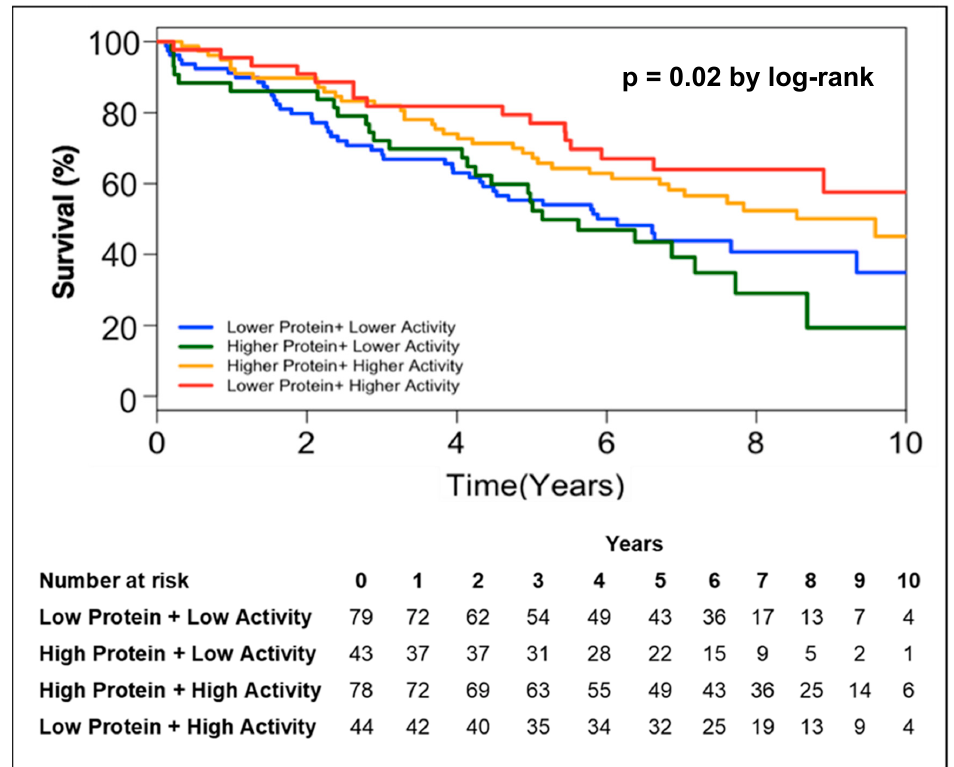
Figure 3. Kaplan–Meier analysis for mortality in patients with CKD stratified by lower protein + higher lactonase activity, higher protein + higher lactonase activity, higher protein + lower lactonase activity, and lower protein + lower lactonase activity.